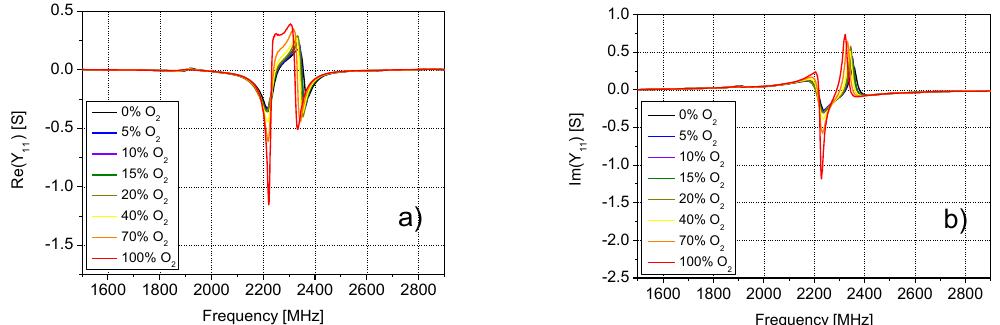
Figure 7. Frequency dependence of the ( a ) real and ( b ) imaginary parts of the admittance parameters Y 21 and Y 12 at 70% of O 2 concentration.